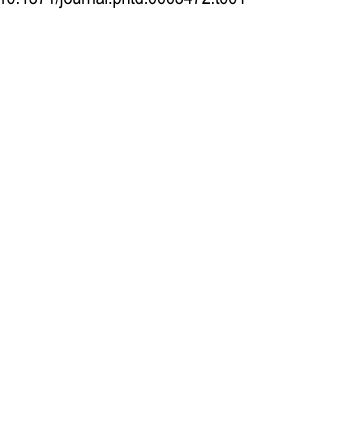
schistosomiasis was associated with higher prevalence of renal dysfunction (OR = 1.3 (1+) vs. OR (cid:4) 4 (2+/3+), p for trend = 0.001). By multivariable logistic regression analysis including schistosomiasis, age, sex and HIV status, schistosomiasis remained the only factor associated with renal dysfunction (OR = 2.40, 95%CI 1.37 – 4.17, p = 0.002). HIV infection was not signifi- cantly associated with renal dysfunction by either univariable or multivariable analysis. There was more renal dysfunction among children with higher WHO clinical stage, but this relation- ship was not statistically significant (p = 0.23). Of note, though, the association between schis- tosomiasis and renal dysfunction was somewhat stronger among HIV-infected children than their HIV-uninfected siblings (OR = 3.04, 95%CI 1.39 – 6.68, p = 0.005 vs. OR = 2.08, 95%CI 0.97 – 4.46, p = 0.06).